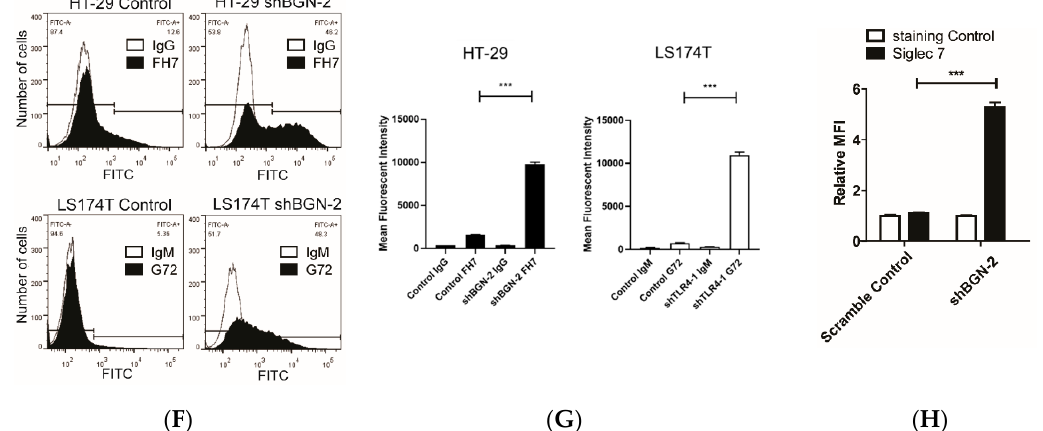
Figure 2. Identification of BGN as a potential TLR4 ligand involved in suppression of Siglec ligands in the early stage of colon cancer carcinogenesis. ( A ) Gene expression analysis of TLR4 ligands—BGN, HSPD1, HMGB1, S100A8, S100A9, TNC, heparan sulfate proteoglycan active enzymes (SDC2 or HSPG2), hyaluronidases (HYAL1 and HYAL2) and hyaluronan synthase (HAS1, HAS2, and HAS3)—in normal ( n = 397) and colon cancer samples ( n = 3775) from the GENT2 database. ***, p < 0.001. Results are shown as the relative fold increase compared with normal colon control. ( B ) Comparison of BGN, S100A8, S100A9, and TNC amount expression in COAD and READ by GEPIA2. Gene expression level was calculated by transcript per million (TPM). ( C ) Large-scale RNA-Seq transcriptome analysis of BGN in healthy colorectal tissues and tissues from four stages of colorectal cancer from the TCGA database. n, number of patients; *** p < 0.001. ( D ) BGN was inversely correlated with the overall survival of patients with colorectal cancer. Overall survival analyses were performed using the GEPIA2 online platform. The solid line shows the survival curve, and the dotted line shows the 95% confidence interval. Red lines indicate patients with expression above the median, and blue lines indicate patients with expression below the median. Log-rank p < 0.05 was considered statistically significant. HR, hazard ratio. ( E ) BGN expression in HT-29 and LS174T after the administration of shRNAs for BGN. ( F ) Flow cytometry analysis of expression of disialyl Lewis a on HT-29 cells (top panels) and sialyl 6- sulfo Lewis x on LS174T cells (bottom panels), after the administration of shRNAs for BGN. ( G ) Fluorescence intensity results of flow cytometry analysis in ( H ) are shown. The relative expression levels of disialyl Lewis a and sialyl 6-sulfo Lewis x are shown as mean fluorescence intensity (MFI) compared with the staining of control IgG or IgM. *** p < 0.001. ( H ) Restoration of Siglec-7 binding by introduction of shRNAs for BGN in LS174T colon cancer cells. The relative levels of Siglec-7 are shown as the relative mean fluorescence intensity (MFI) compared with the control group IgG. *** p < 0.001.